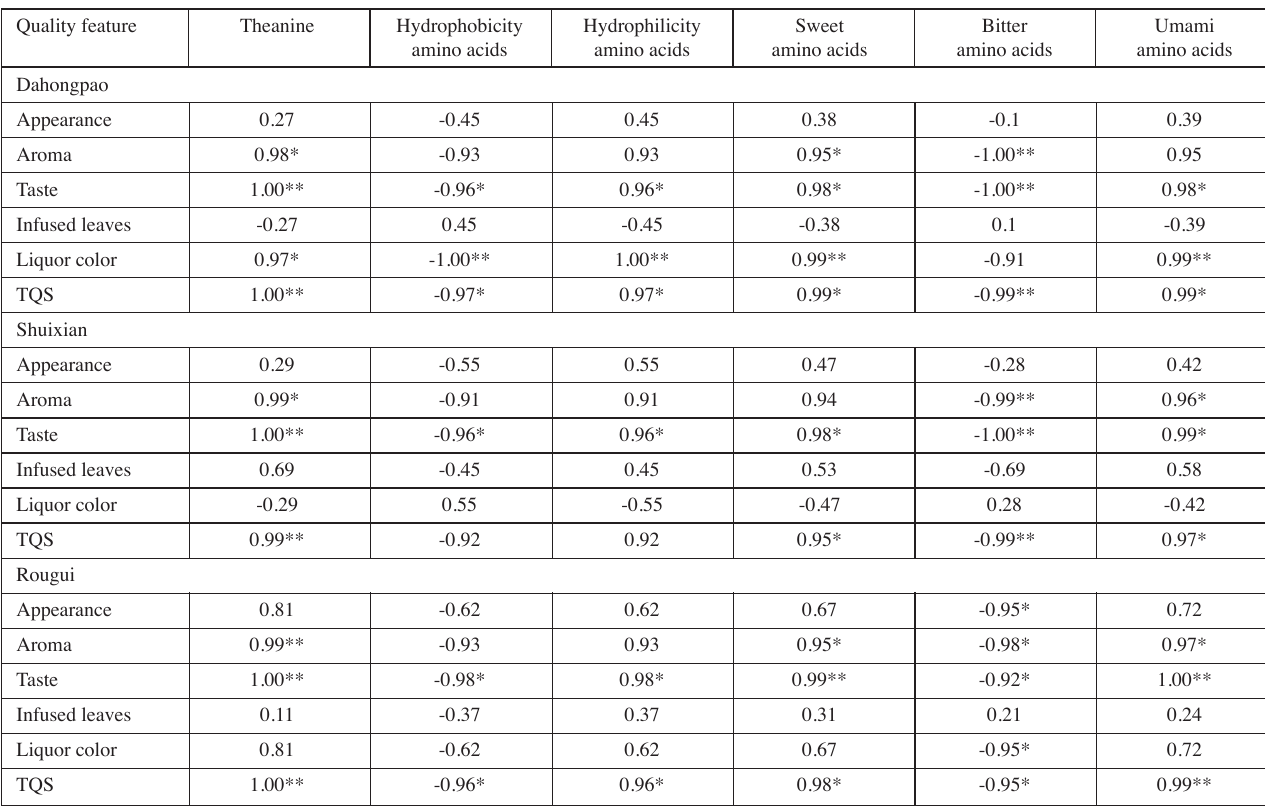
Tab. 3: Correlation between the score of sensory evaluation and the proportion of characteristic amino acids